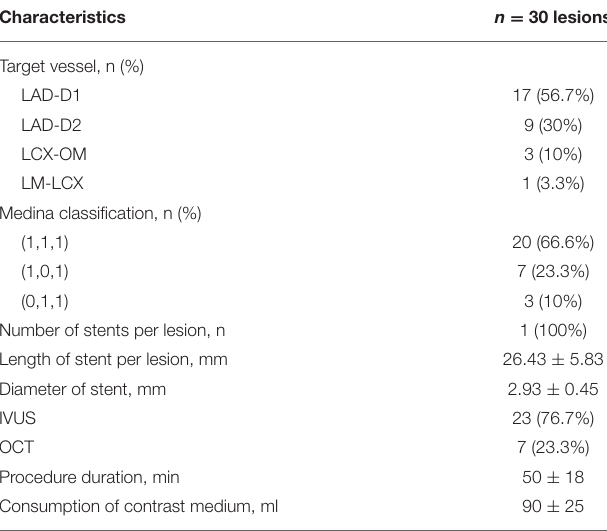
TABLE 2 | Angiographic and procedural characteristics.